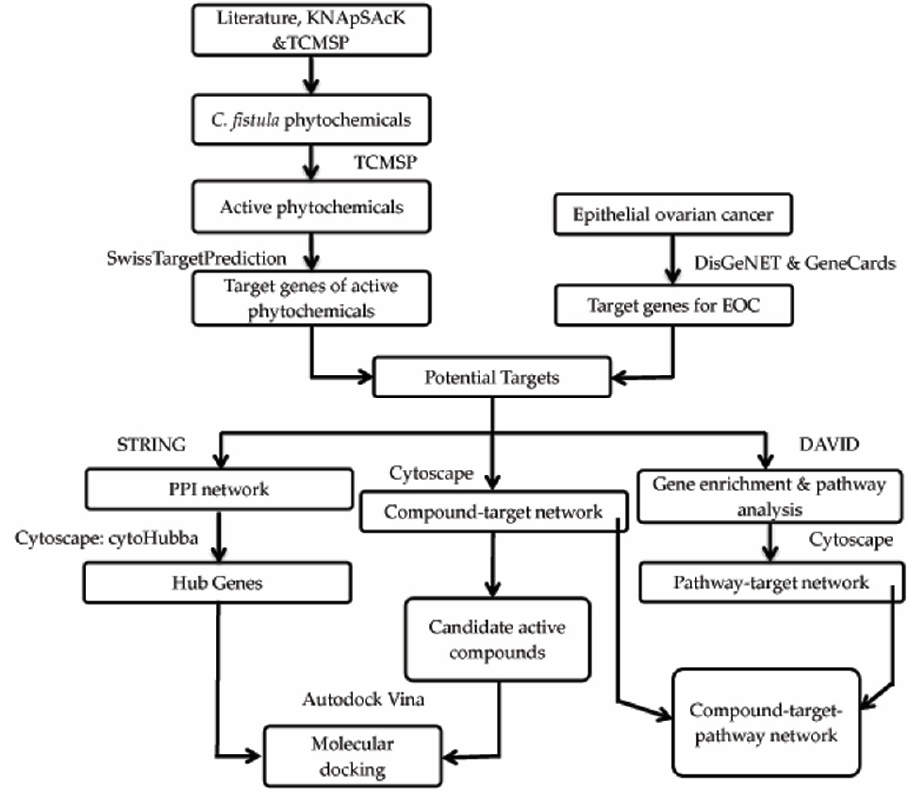
Figure 1. The network pharmacology and molecular docking techniques employed in order to predict C. fistula’s potential drug targets for the treatment of EOC depicted graphically.